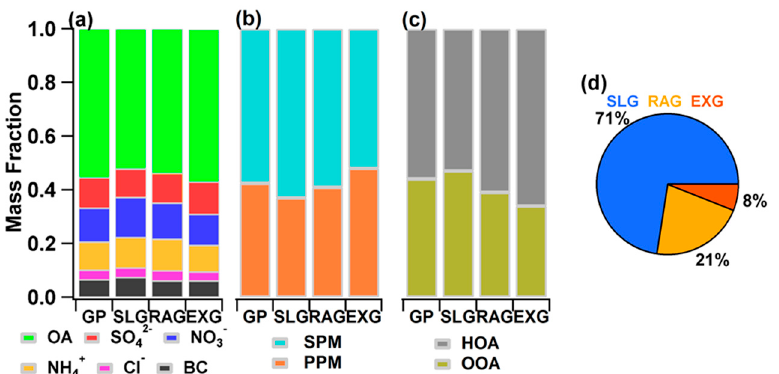
Figure 8. Average mass fractions of PM species (( a ): Org, SO 42 − , NO 3 − , NH 4+ , Chl, and BC) (( b ): SPM and PPM) and OA factors (( c ): HOA and OOA) in increasing concentration during GP, SLG, RAG, and EXG and the proportion of the three growth methods in the total growth ( d ) in Beijing.